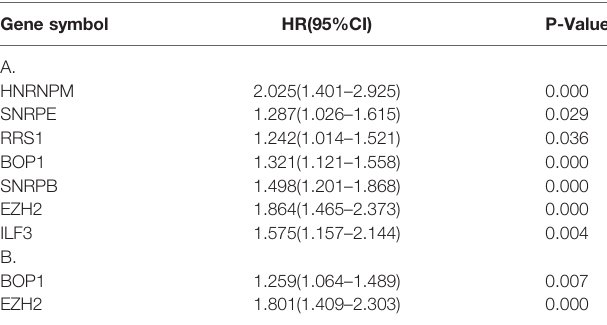
TABLE 2 | Association between genes expression and overall survival in HCC patients.